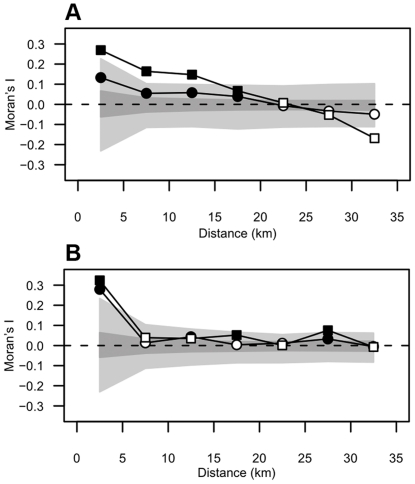
Moran's I correlograms of An. gambiae (A) and An. funestus (B).Circles and squares represent Moran's I values at the house level and at the locality level, respectively. Filled symbols indicate statistically significant individual lags (p<0.05). Envelopes of 95% confidence intervals are shown in light grey (locality level) and dark grey (house level).